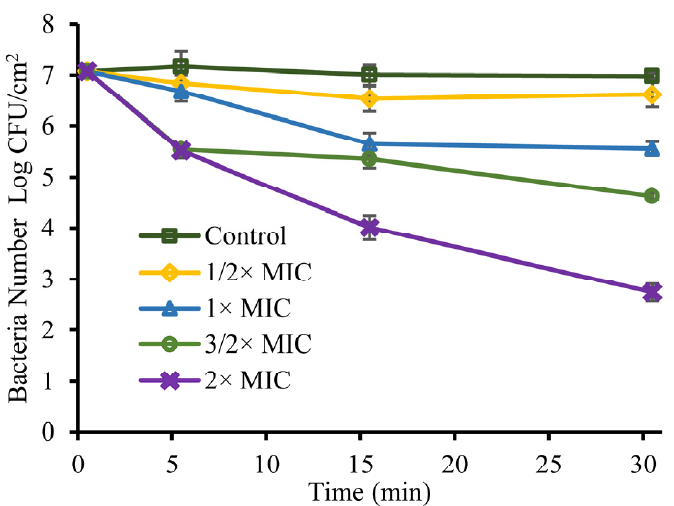
Figure 8. The antibacterial curve of linalool against S. sonnei on the lettuce surface. Bars represent the standard deviation ( n = 3).